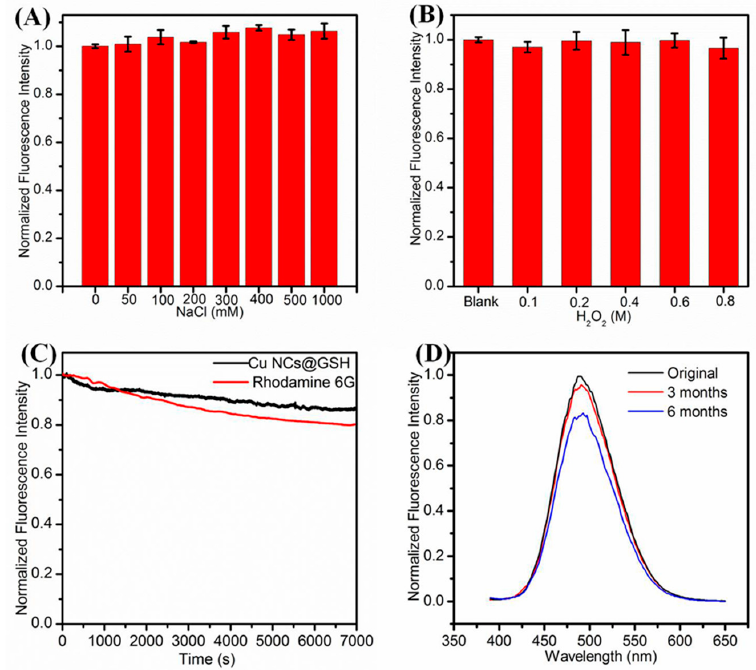
Figure 4. Effect of ( A ) Ionic strength; ( B ) concentration of H 2 O 2 ; ( C ) irradiation time; ( D ) storage time on the fluorescence intensity of Cu NCs.